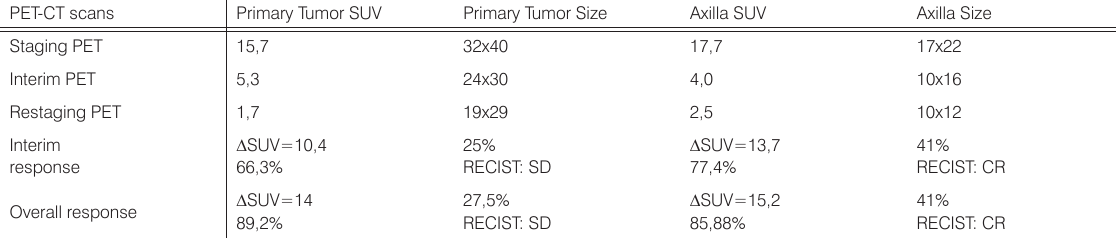
Table 1. FDG-PET-CT results